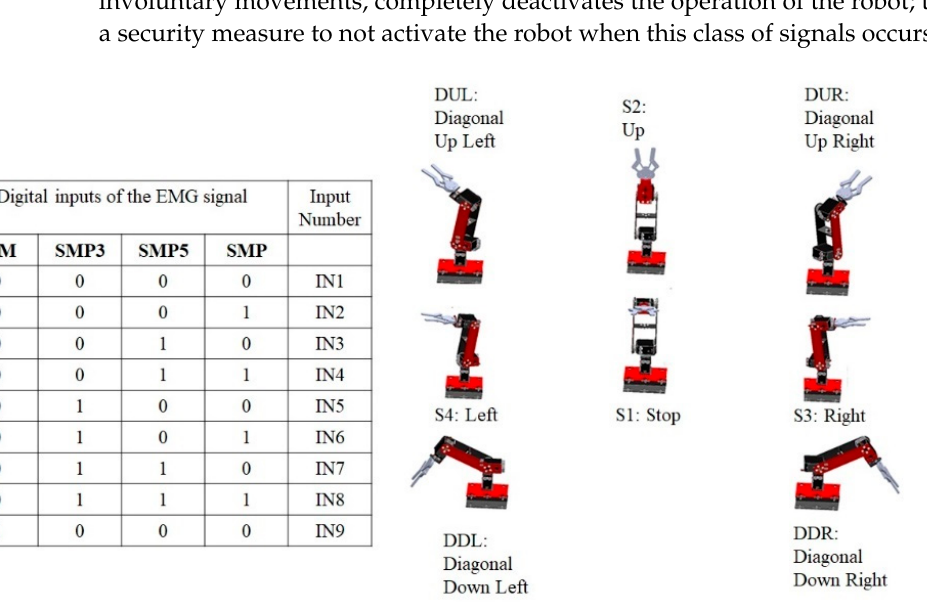
Figure 13. The table presents the inputs of the digital system, and the system outputs are indicated by means of the robot diagram.